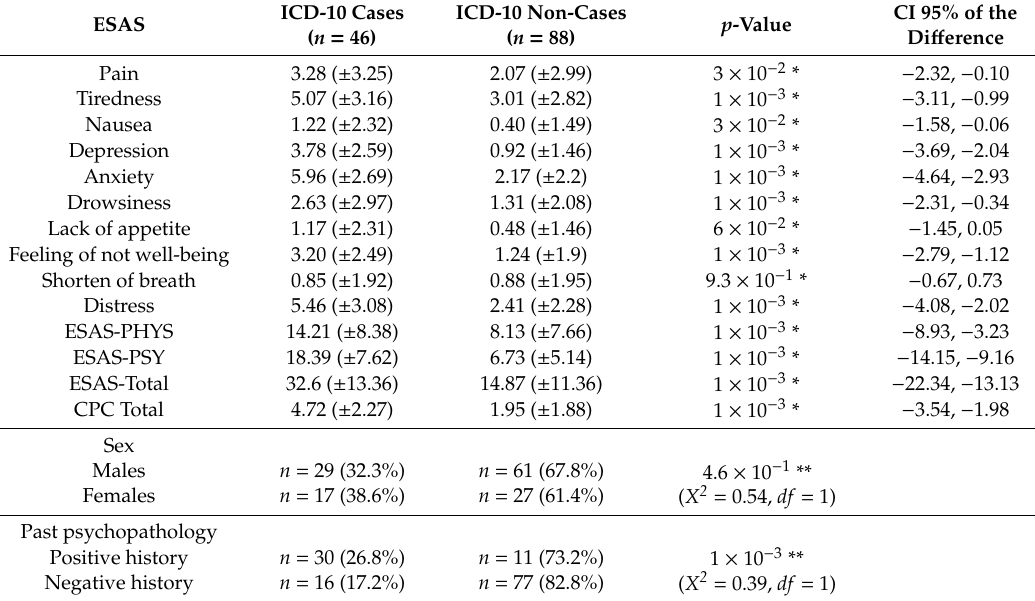
Table 2. Mean (SD) scores on the ESAS and clinical characteristics among ICD-10